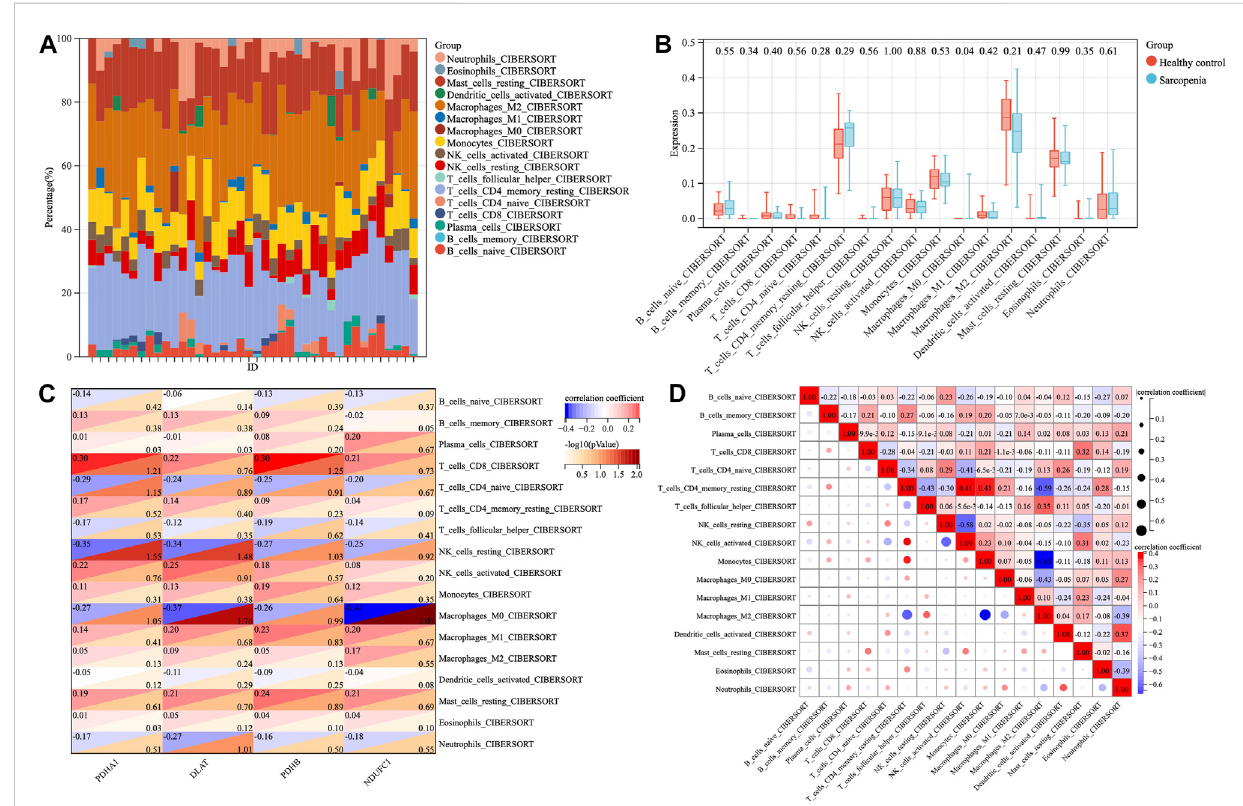
FIGURE 7 The proportions and correlations of immune cells among sarcopenia group and healthy control group. (A) The relative abundance of 17 distinct immune cells subsets. (B) The expression levels of immune cells shown in box plots among sarcopenia group and healthy control group, p < 0.05indicatedstatisticaldifference. (C) Thespearman ’ correlationofeachhubgenewithdifferentimmunecellsubsets.Therowscorrespondtoimmune cell subsets and each columns represents a hub gene. Each cell contains the correlation coef fi cient (upper number) and -log10 ( p value) (lower number). (D) The correlations between different populations of immune cell